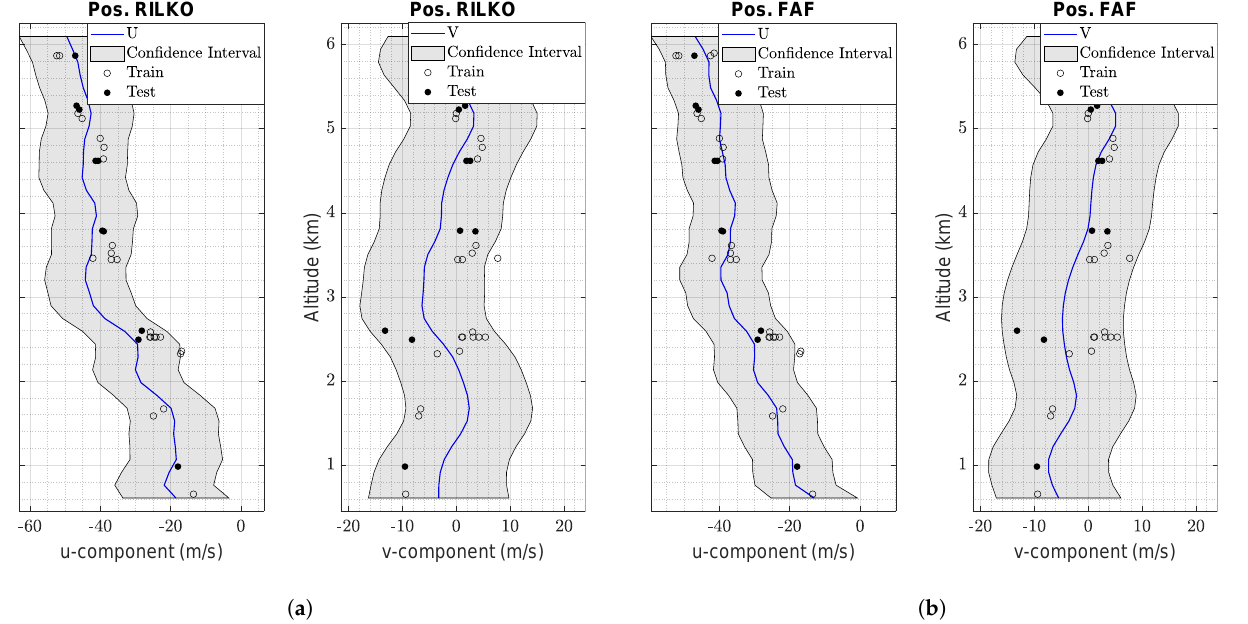
Figure 8. Confidence intervals for the VWP estimated using the GPR technique along with the training and testing data available at time 14:10 UTC. ( a ) Confidence interval for the VWP estimated at RILKO IAF waypoint. ( b ) Confidence interval for the VWP estimated at FAF